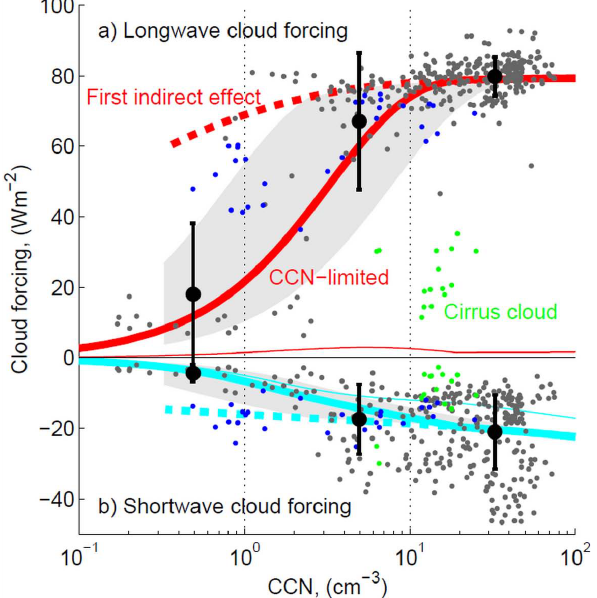
Fig. 17. Surface (a) longwave and (b) shortwave cloud radiative forcing as a function of CCN number concentration. CCN measure- ments were made at a supersaturation of 0.2%. Dots are hourly observations; lines are idealized radiative transfer calculations de- scribed in the text. Dashed lines represent the first aerosol indirect effect only. Solid thick lines correspond to cloud liquid content be- ing limited by effective radius R e <15µm. The grey shaded areas show the sensitivity to critical R e values between 10 and 30µm. Thin solid lines are the long- and shortwave cloud forcing at the top of the atmosphere. Large black dots are bin-averaged values for each decade of CCN concentration, and bars indicate the stan- dard deviation from the decade mean. Green markers are related to a single case with mid-tropospheric ice clouds that are radiatively very different from low-level stratus cloud, and the CCN concentra- tion measured near the surface is not relevant for these clouds. Blue markers are cases for which the CCN measurement is particularly sensitive to the choice of supersaturation, due to a steep cumulative size distribution near the critical size for activation at the supersat- uration used. Figure is from Mauritsen et al. (2011).